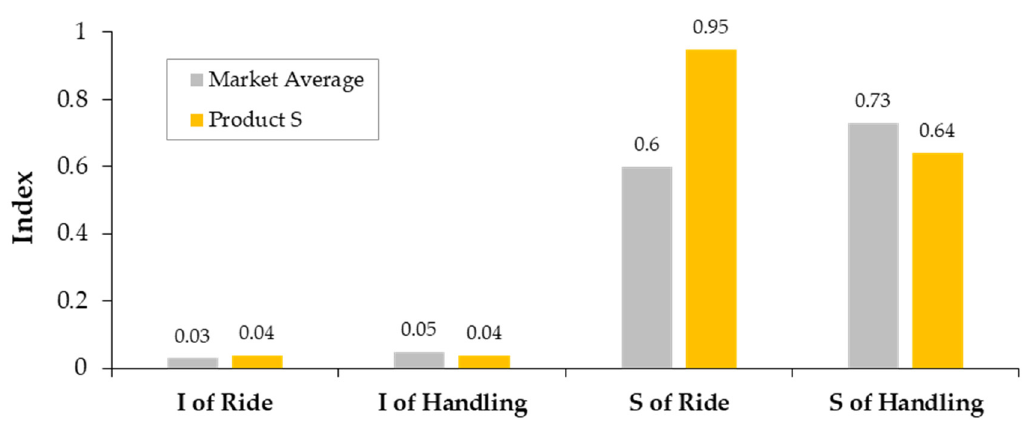
Figure 12. Importance and satisfaction of ride and handling in South Korean subcompact SUV market.